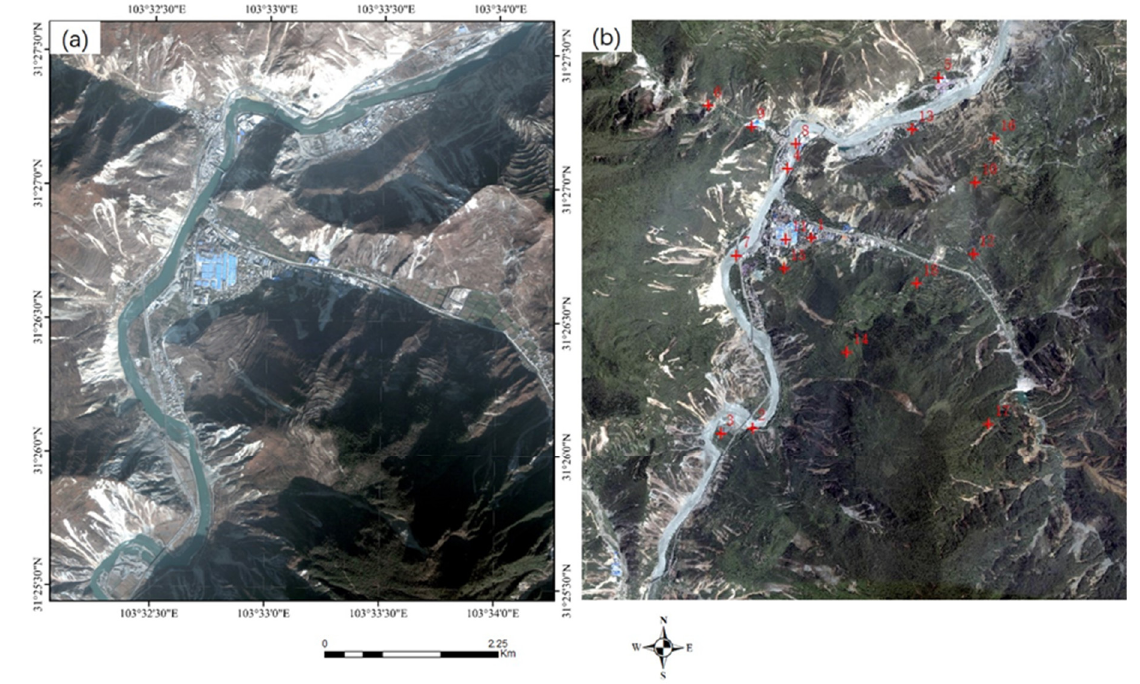
Figure 6. HR multispectral images with disaster of P-C. ( a ) QuickBird image (input image), ( b ) GE image (reference image). Points in red are verification points.